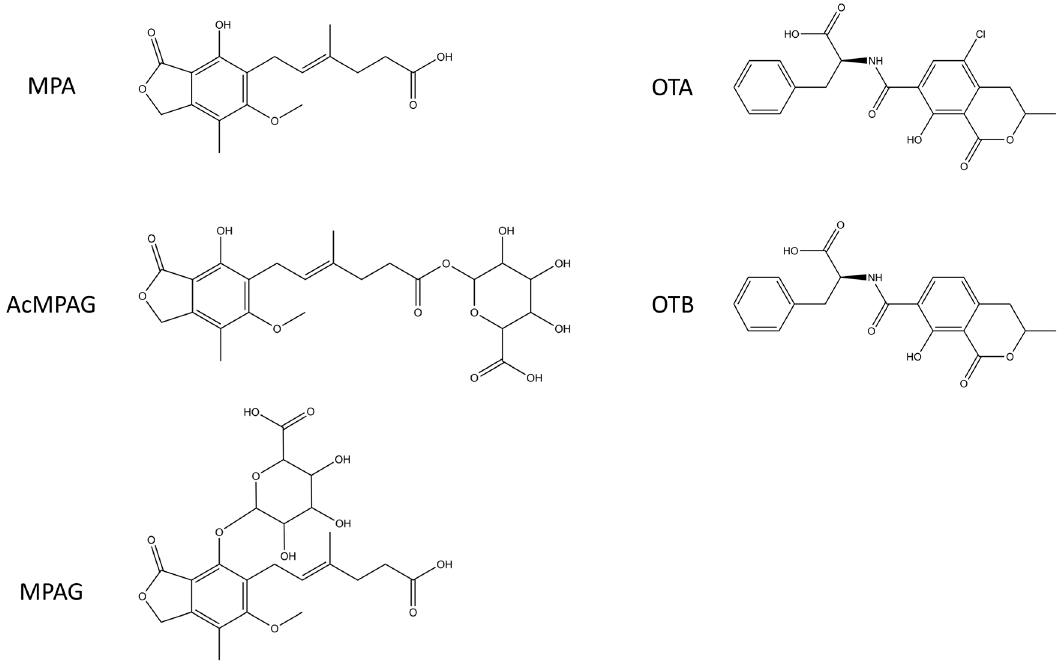
Figure 2. Chemical structures of the analytes used in the affinity measurements. Drawn with CambridgeSoft ChemBioDraw 12 (Perkin Elmer, Waltham, MA, USA). AcMPAG, mycophenolic acid acyl-glucuronide; MPAG, mycophenolic acid glucuronide; OTA, ochratoxin A and OTB, ochratoxin B.